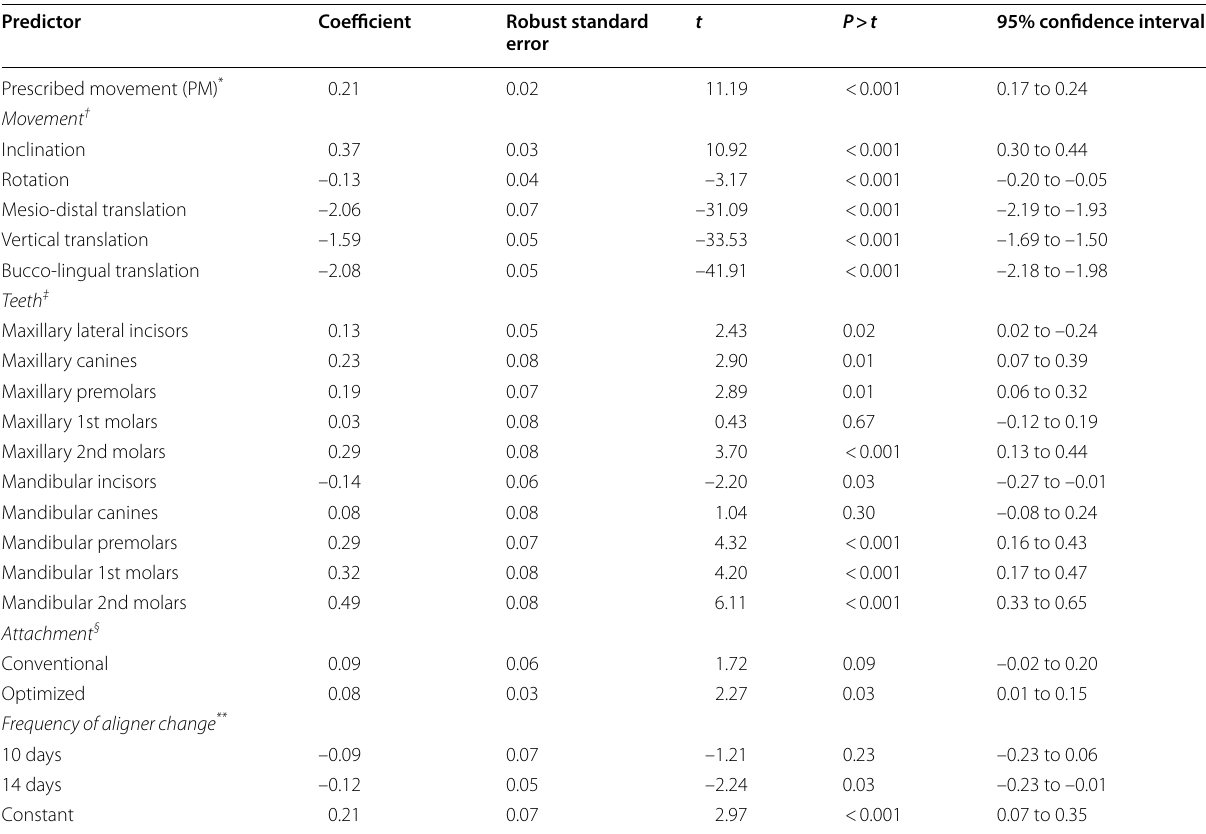
Table 3 Multiple linear regression output. The primary outcome lack of correction (LC) and the exposure prescribed movement (PM) were normalized by means a logarithmic